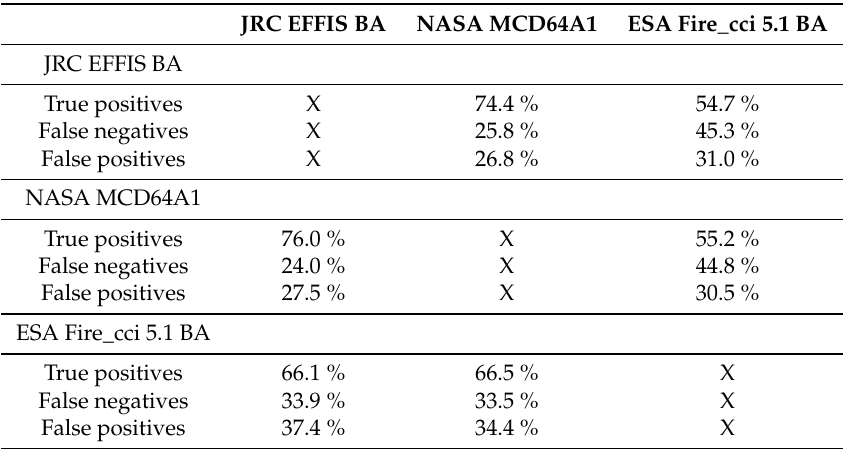
Table 4. Inter-comparison of BA reference